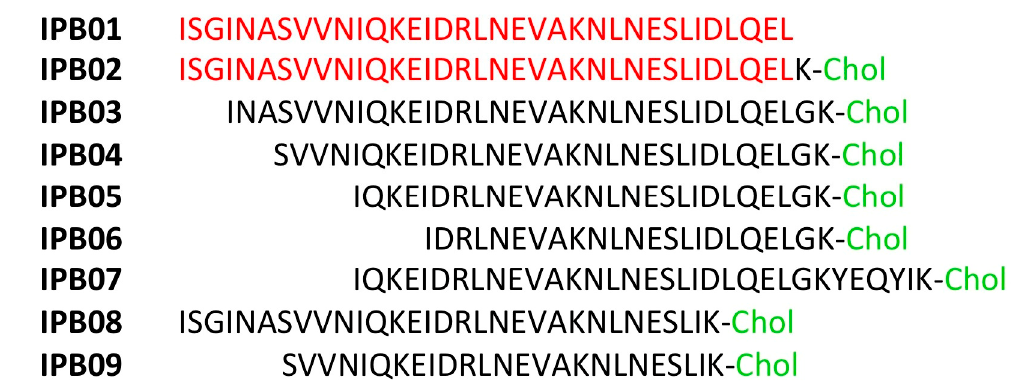
Figure 9. SARS-CoV-2 HR2-derived peptides.